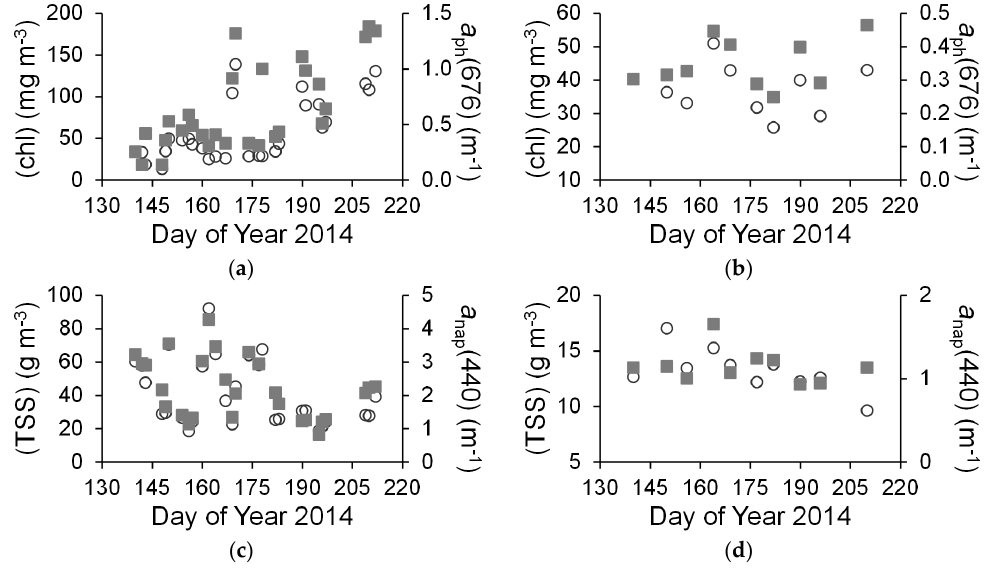
Figure 6. Scatterplots of measured inherent optical properties (filled squares) versus water quality parameters (circles) of the Wabash River (left panel) and the Tippecanoe River (right panel): ( a ) and ( b )—absorption of phytoplankton at 676 nm ( a ph (676)) vs. chlorophyll concentrations ((chl)); ( c ) and ( d )—absorption of non-algal particles at 440 nm ( a nap (440)) vs. concentrations of total suspended sediments ((TSS)).